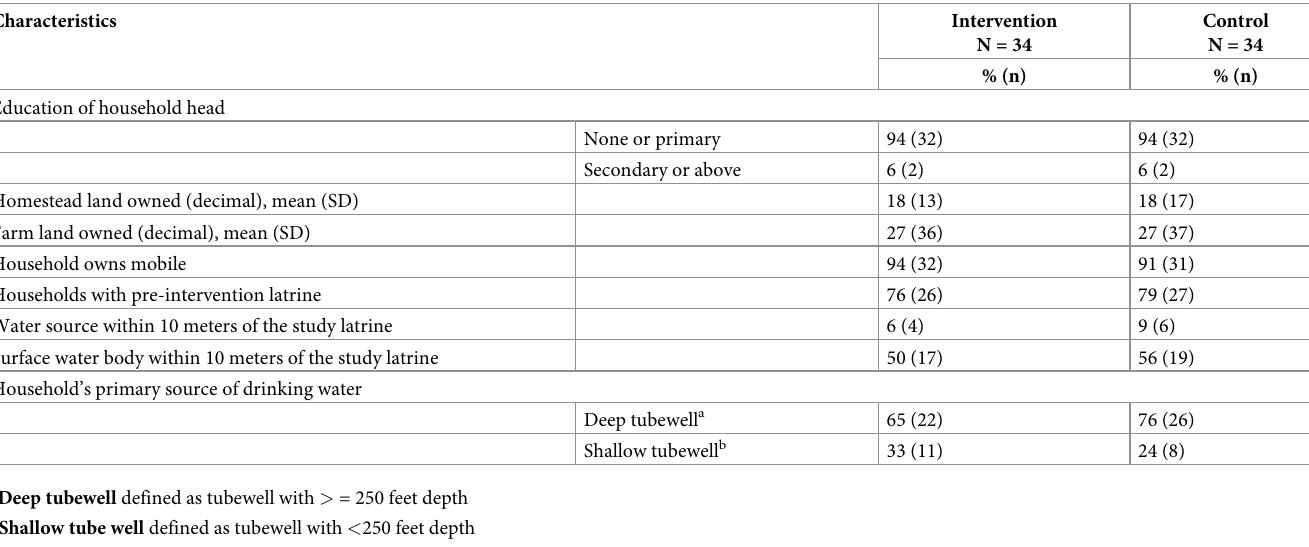
Table 1. Baseline characteristics of the intervention and control